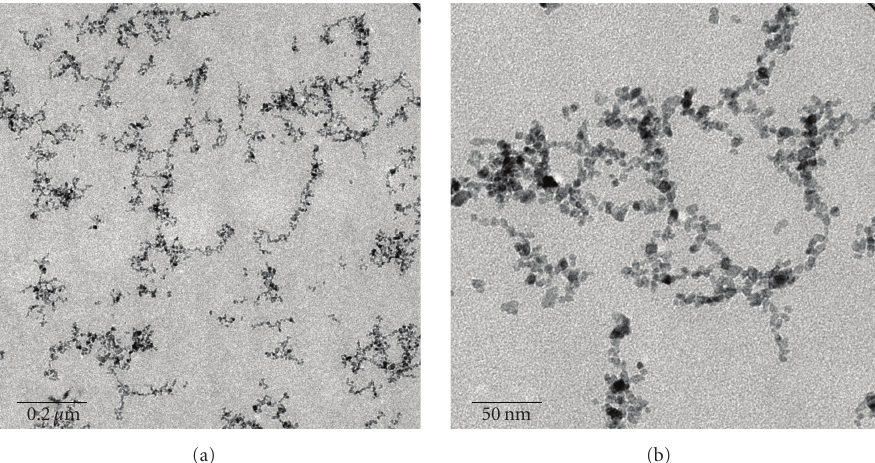
Figure 1: TEM images of cured semiconductive Sb:SnO 2 /PEGDA 575 composites at two di ff erent amplifications. Sb doping: 2 at.%; layer thickness 100 nm; particle concentration 0.8 vol.%. The particles were grafted before use with MPS (MPS / Sb : SnO 2 = 0 . 045